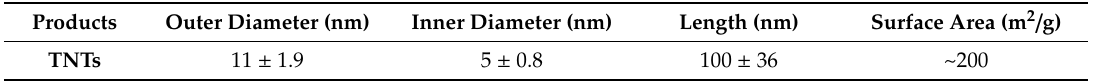
Figure 3. ( a – c ) TEM images of hydrothermally synthesized TNTs. The marked area in ( b ) with lower magnification is shown in higher magnification in ( c ). ( d ) Size distribution of TNTs. Table 3. Physical parameters of